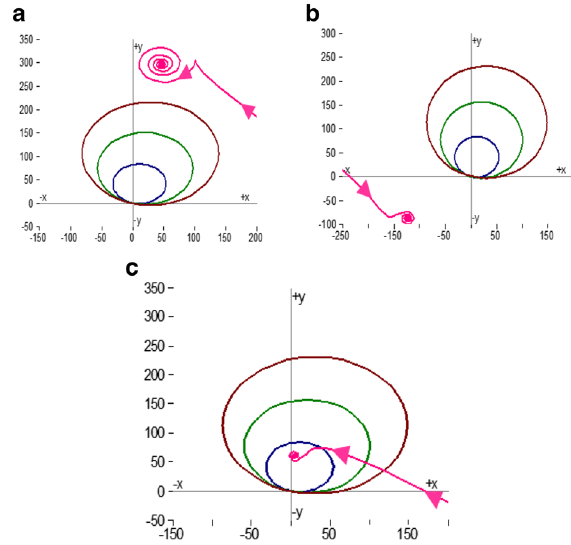
Fig. 3 Performance of ( a ) R 12 , ( b ) R 21 & ( c ) R 23 for LLL (RYB) fault at 10 km from Bus-1 (Zone-1 of R 12 and Zone-2 of R 21 )